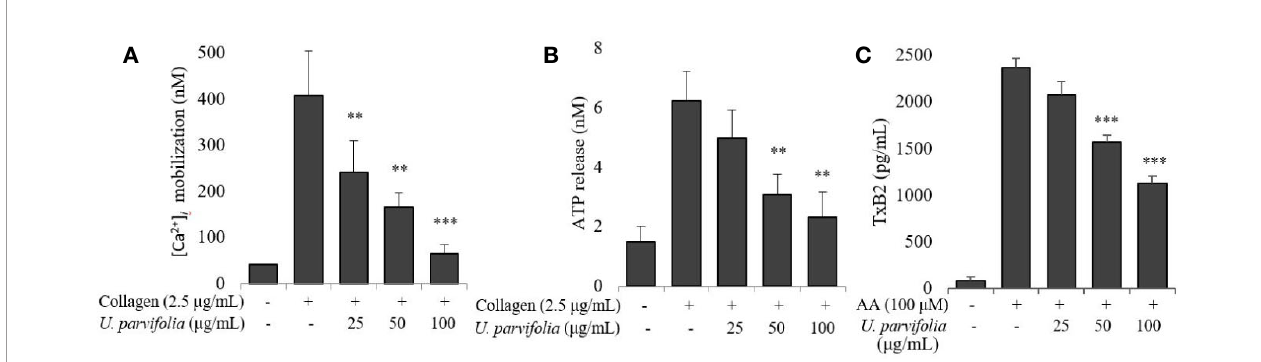
FIGURE 2 | U. parvifolia inhibits [Ca 2+ ] i mobilization and reduces ATP release and TxB2 production. (A) Fura 2/AM-loaded rat platelets pre-treated with vehicle or various U. parvifolia extract concentrations and stimulated with collagen (2.5 µg/ml) for 3 min. Assessment of ATP concentration (B) , and thromboxane-B2 production (C) was done in supernatant of stimulated washed platelets suspension pre-treated with vehicle or various U. parvifolia extract concentrations and stimulated with collagen for 5 min on a luminometer or TxB2 ELISA kit, respectively. Results are represented as mean ± SD values from at least four independent experiments. ** p < 0.01 and *** p < 0.001 versus control.